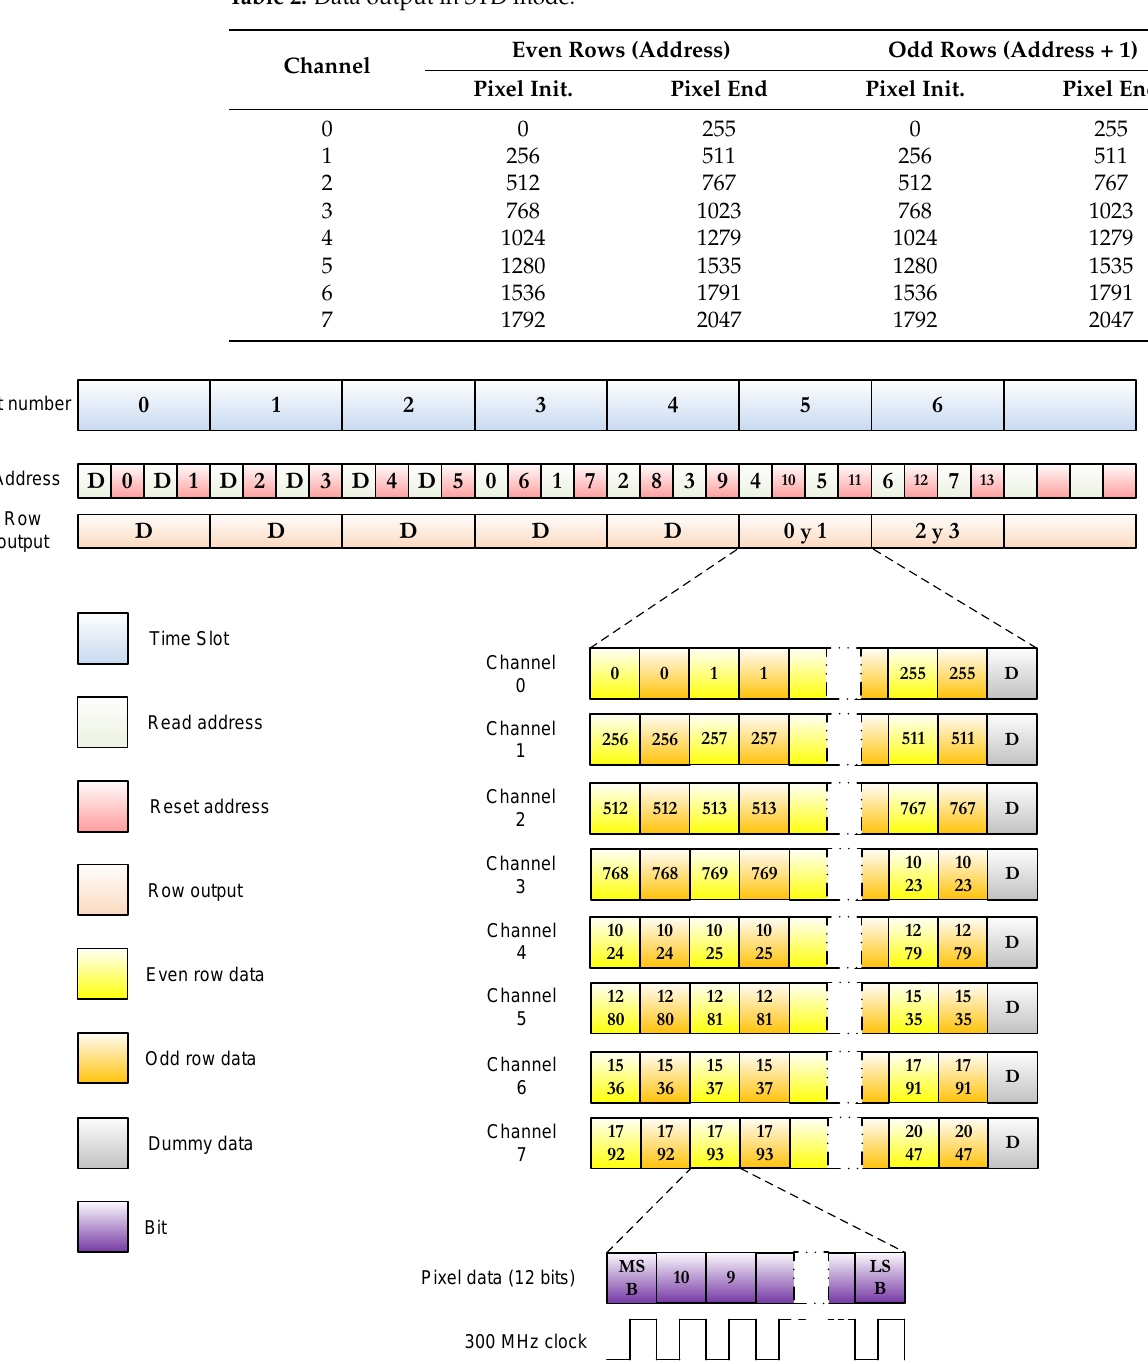
Figure 6. Data output of the sensor in STD mode (standard).